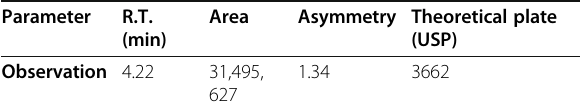
Table 6 Obtained solution for optimized